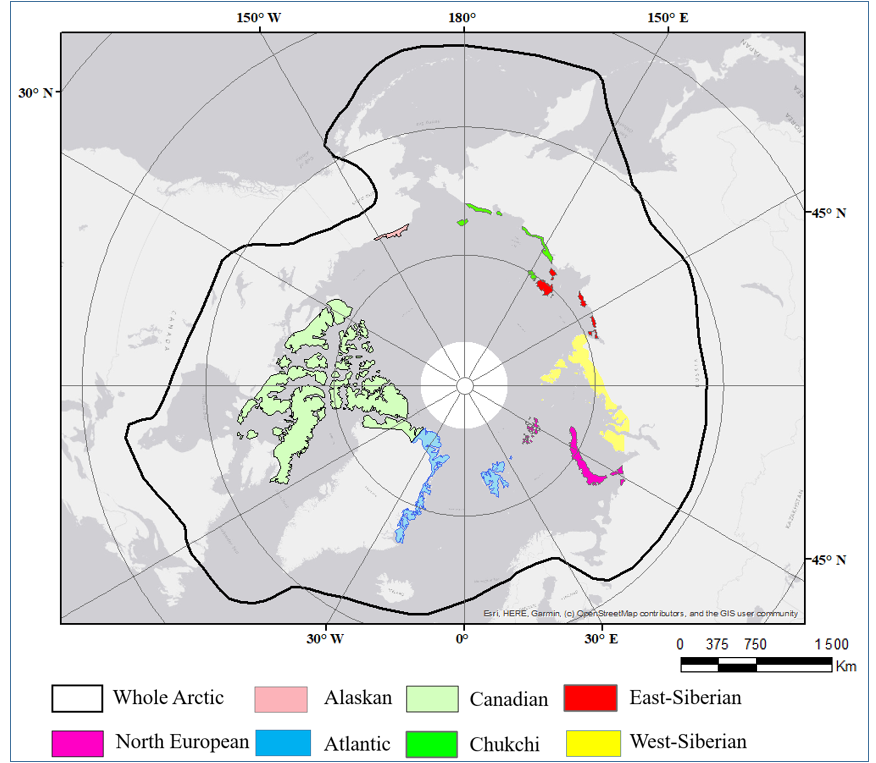
Figure 1. Map of the Northern Hemisphere displaying the High Arctic zones delineated according to the Circumpolar Arctic Vegetation Map [21,22]. Th black line indicates the whole Arctic extent while colored polygons indicate High Arctic